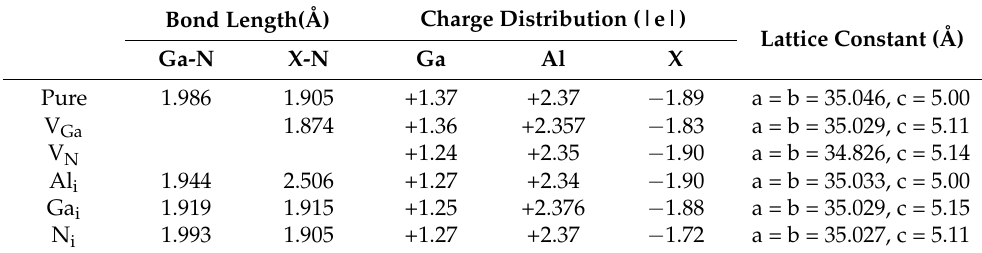
Table 1. Bond length, Barder charge distribution, and lattice constant of Al 0.5 Ga 0.5 N nanowires with interstitial defects and vacancy